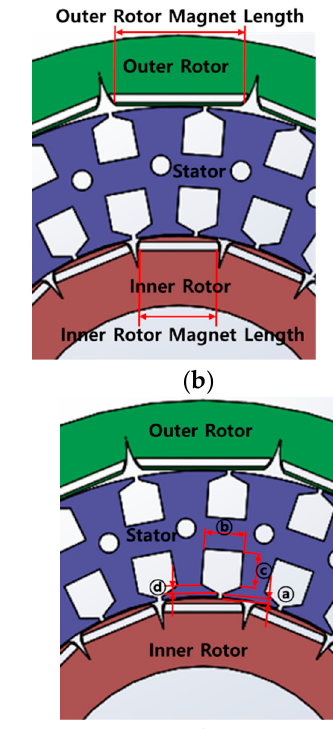
( b ) Figure 5. Analysis of cogging torque according to the dual rotor magnet length. ( a ) Change in permanent magnet length of outer rotor; ( b ) Change in permanent magnet length of inner rotor. The results of Figure 5 are outlined in Table 2. In the early stage, the magnet length for the outer rotors increased from 30 to 40 mm and the inner rotor increased from 14 to 22 mm in increments of 2